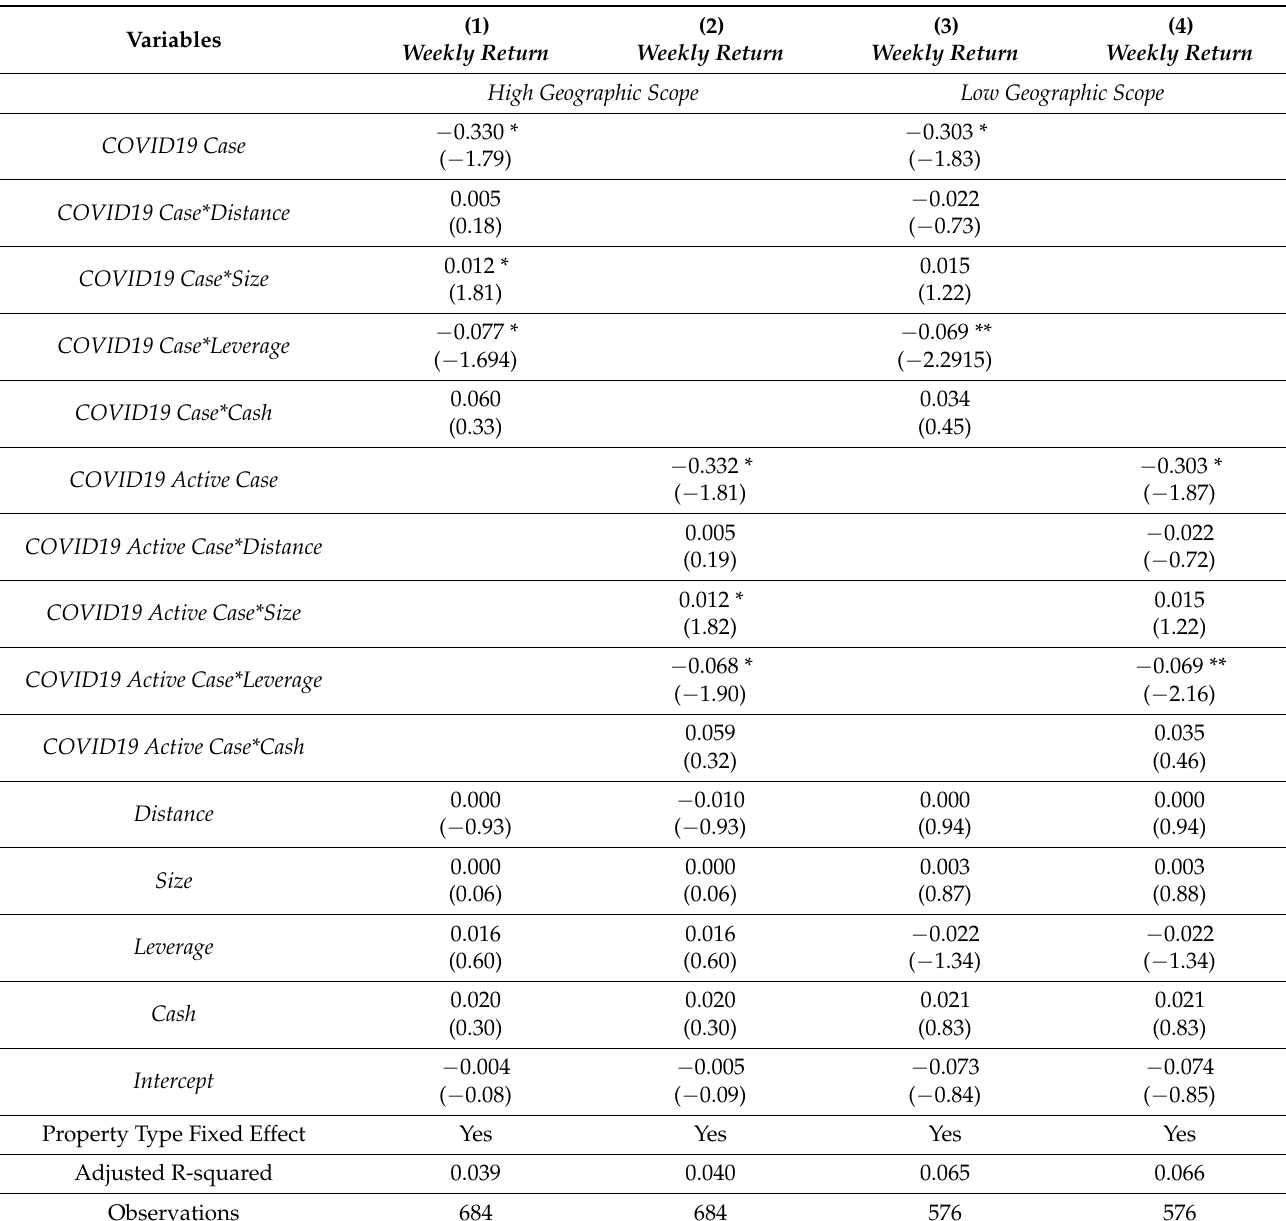
Table 4. Heterogenous analysis of geographic scope and stock market returns during the COVID-19 pandemic.